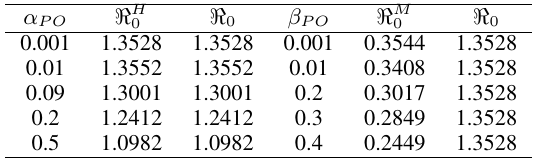
Table IV: Values of the basic reproduction numbers for the parameter α PO and β PO